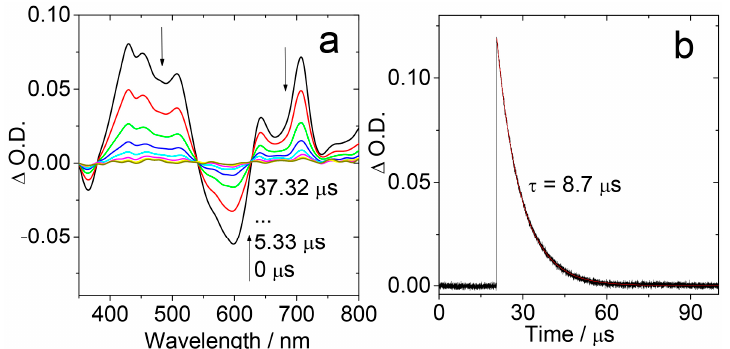
Figure 6. ( a ) Nanosecond transient absorption spectra of NDI-TEMPO ( λ ex = 608 nm). ( b ) Decay trace monitored at 430 nm (black line: experimental spectrum, red line: fitting result). c = 5.0 × 10 − 6 M in toluene, 20 °C. Reproduced with permission from reference [41], copyright 2018, Wiley-VCH.